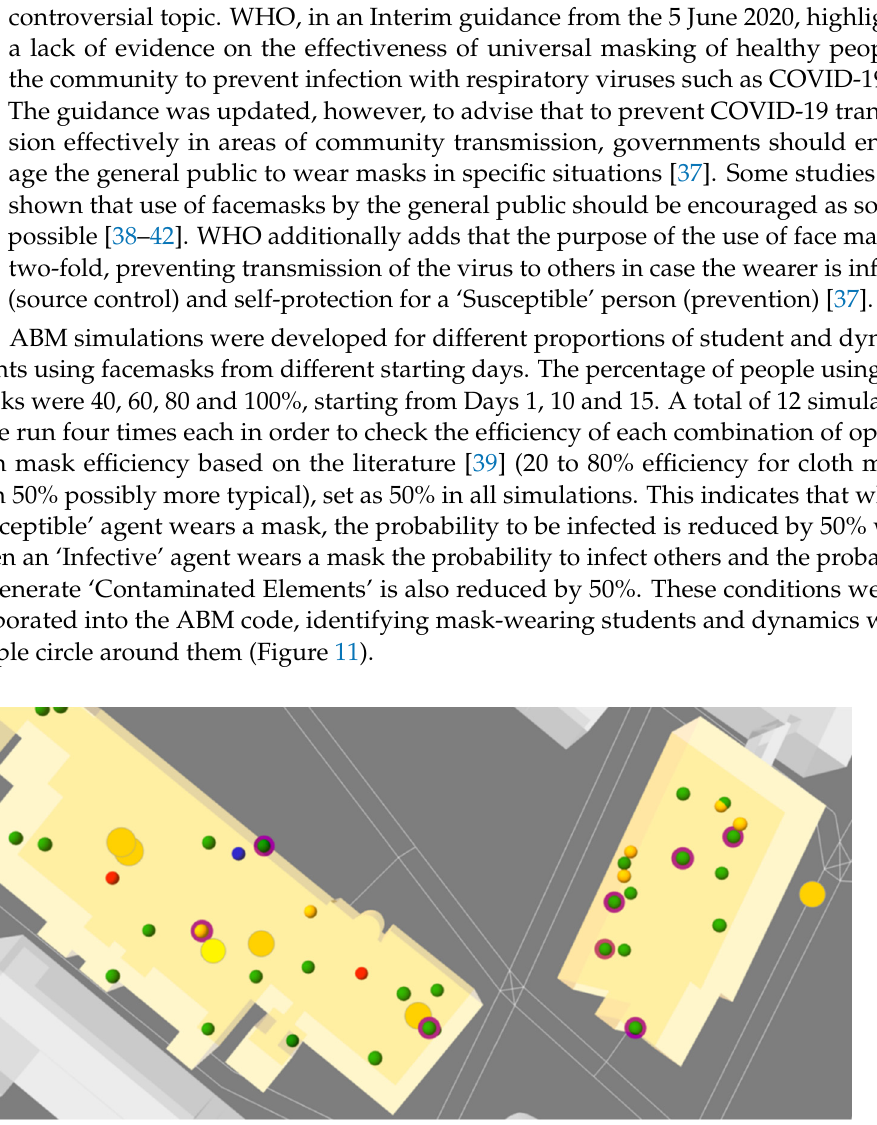
Figure 11. Top detail view of the ABM during a simulation. Different agents appear with different colour (‘Susceptible’ (green), ‘Exposed’ (yellow), ‘Infective’ (red) and ‘Recovered’ (blue)). Addition- ally, some of these agents appear with a purple circle around them, symbolising the use of face- masks. Contains Ordnance Survey data © Crown copyright and database right 2020.